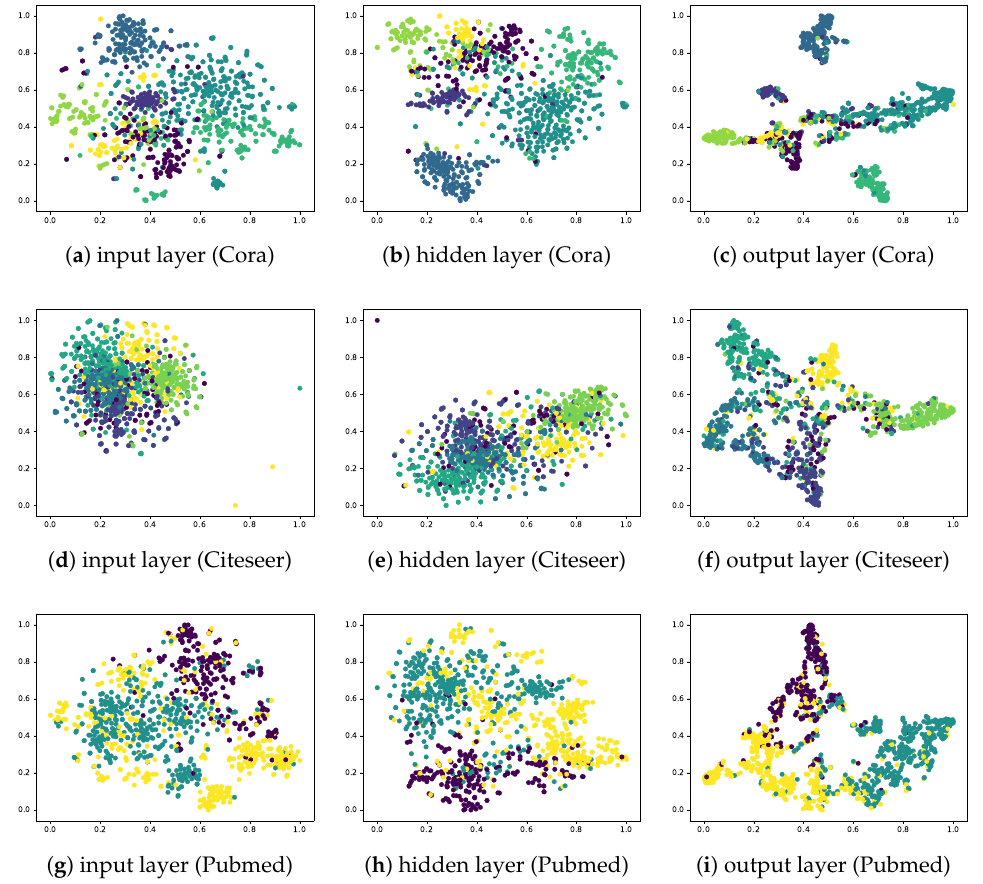
Figure 9. Dimensionality reduction visualization results of node features with FGNN on Cora, Citeseer, and Pubmed (input layer, hidden layer, and output layer). Nodes with different colors represent different categories, and the distance of each point is the 2D visualization of nodes features with t-SNE method.